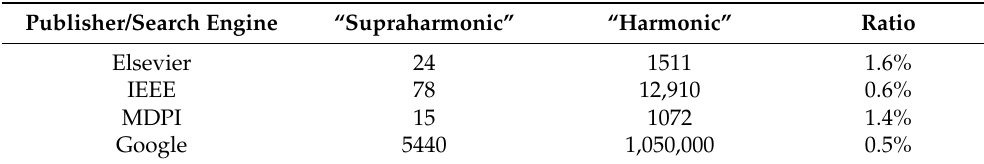
Table 2. Results of the hits of bibliographic search (set1): columns “Supraharmonic” and “Harmonic” refer to the use of the two respective keywords.